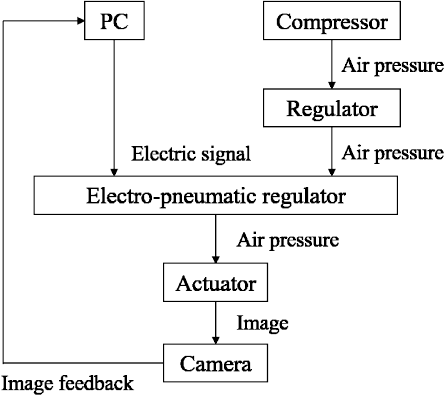
Figure 10. Experimental flow.